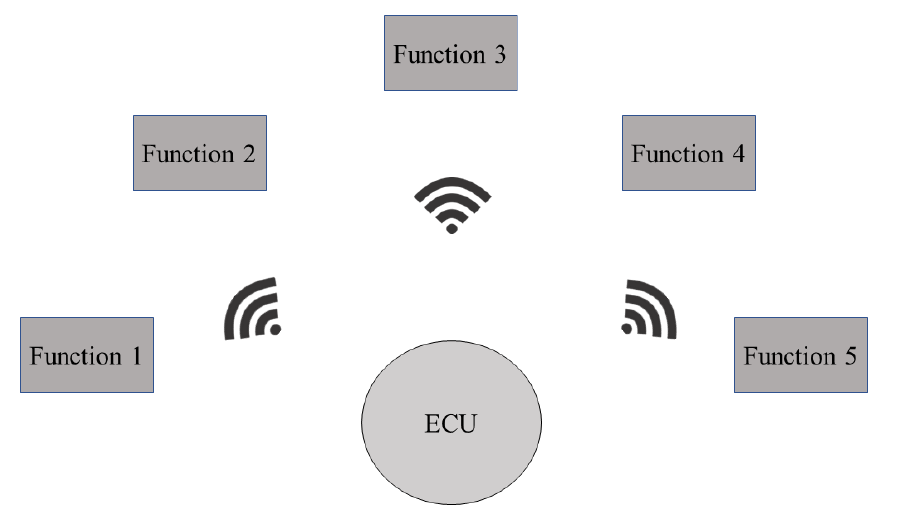
Figure 21. Representation of Wireless Communication